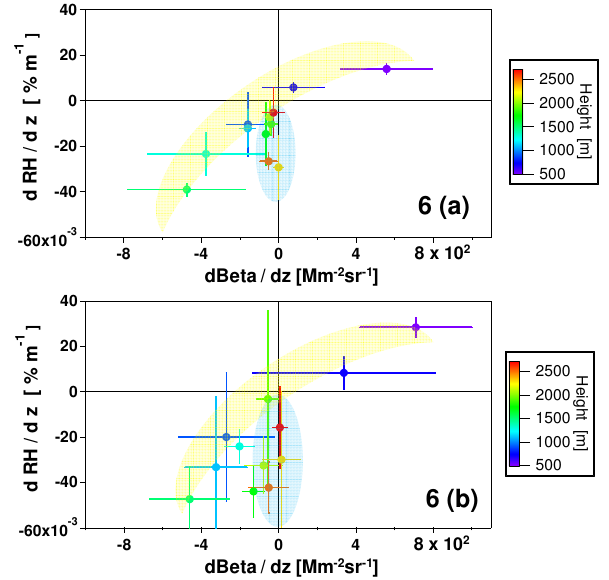
Fig. 6. Relationship between the first derivatives as a function of the height of aerosol backscatter (Beta) and relative humidity (RH) vertical profiles: (a) by using the points from 500m to 3000m a.g.l. (averaged every 200m) of one pair of Beta and RH vertical profiles obtained by averaging 14 available profile pairs; (b) by using the points from 500m to 3000m a.g.l. (averaged every 200m) of one pair of Beta and RH vertical profiles obtained by averaging a subset of 4 profile pairs. Error bars indicate ± 1 standard deviation of the means. Yellow and blue coloured areas indicate the SML + DRCL and the free troposphere,